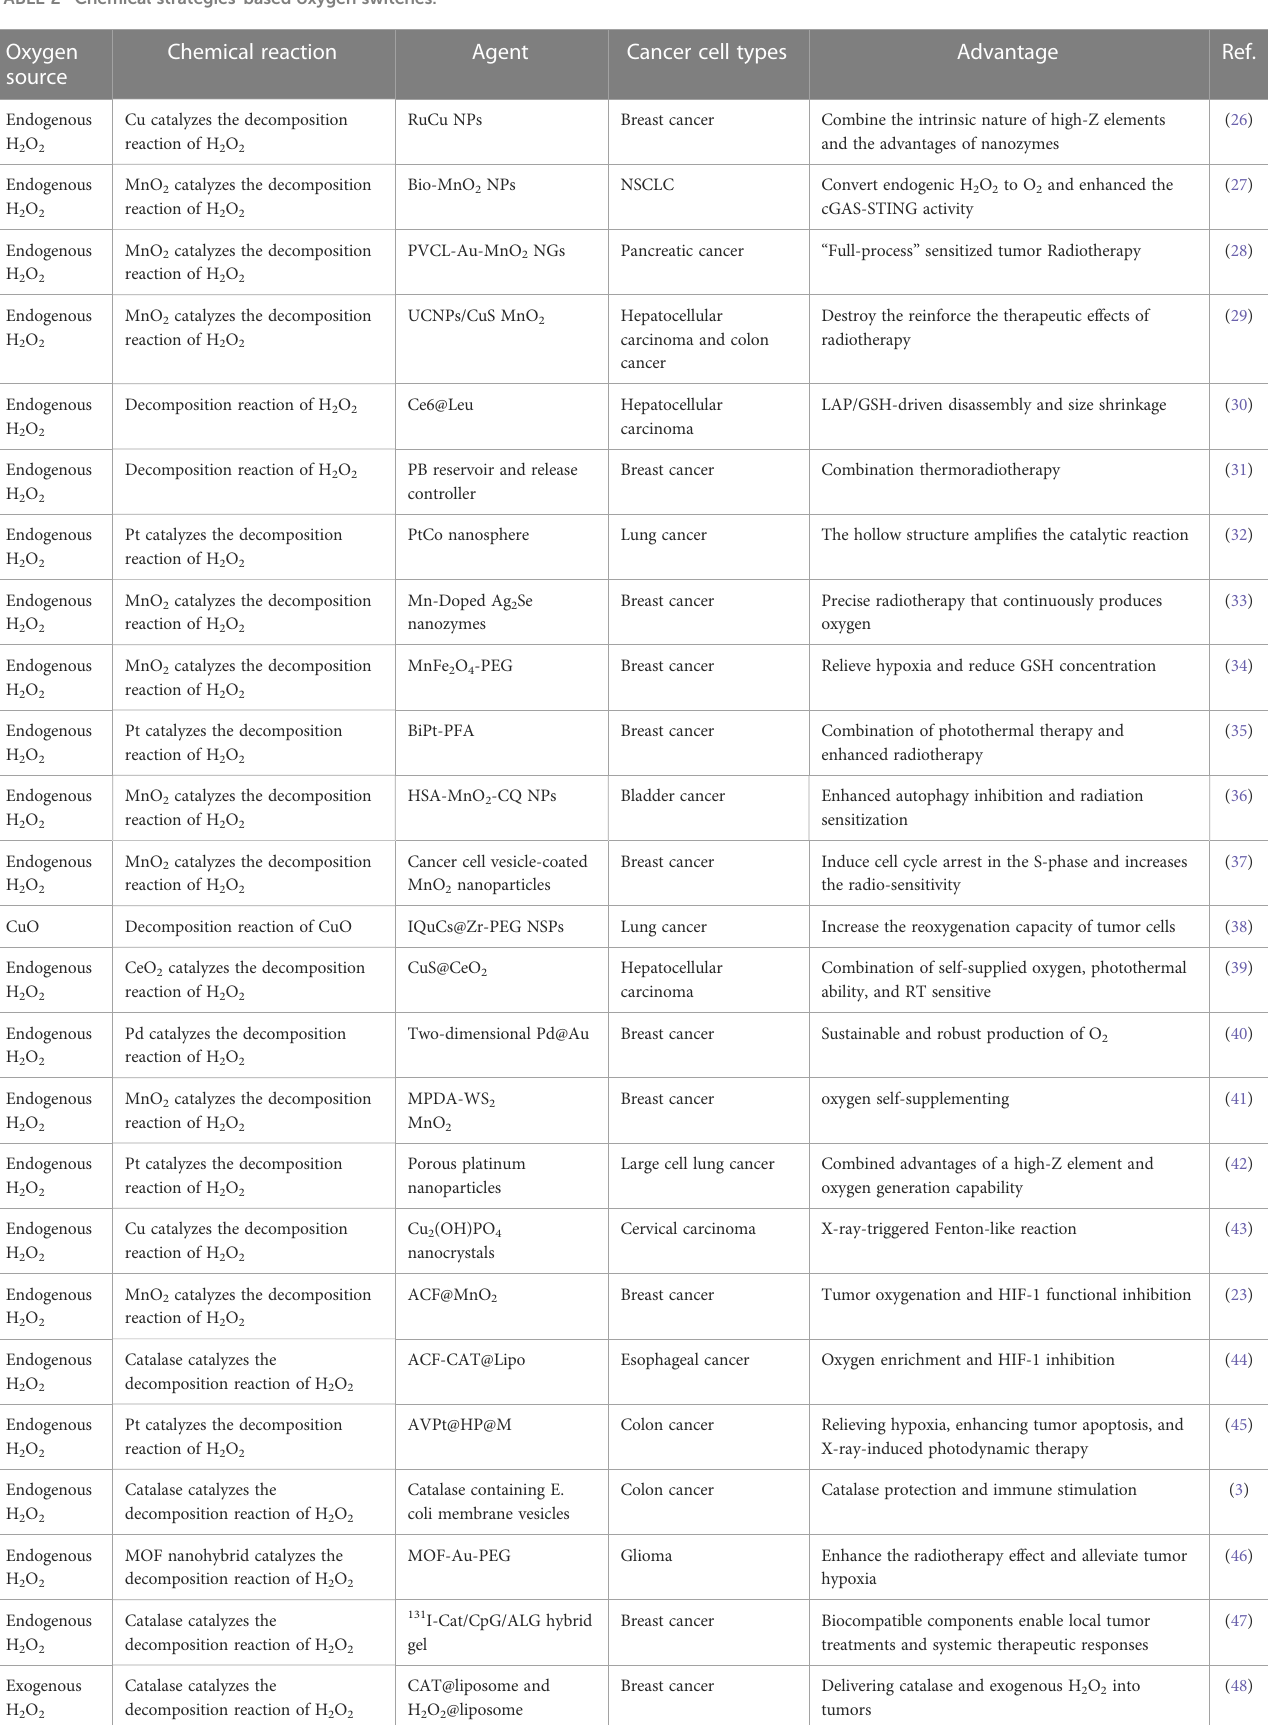
TABLE 2 Chemical strategies-based oxygen